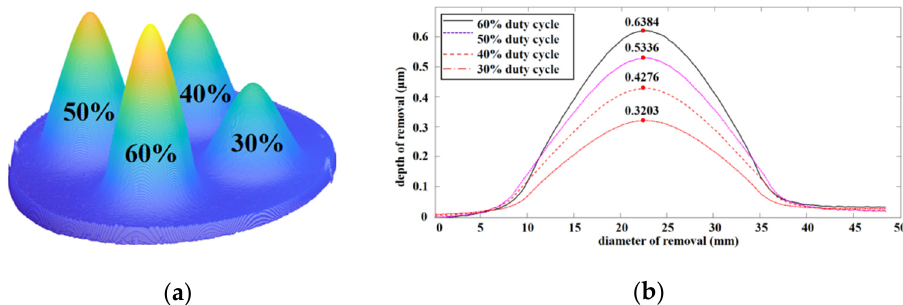
Figure 6. Removal models for different duty cycles: ( a ) material removal model; ( b ) removal depth curves of different duty cycles.